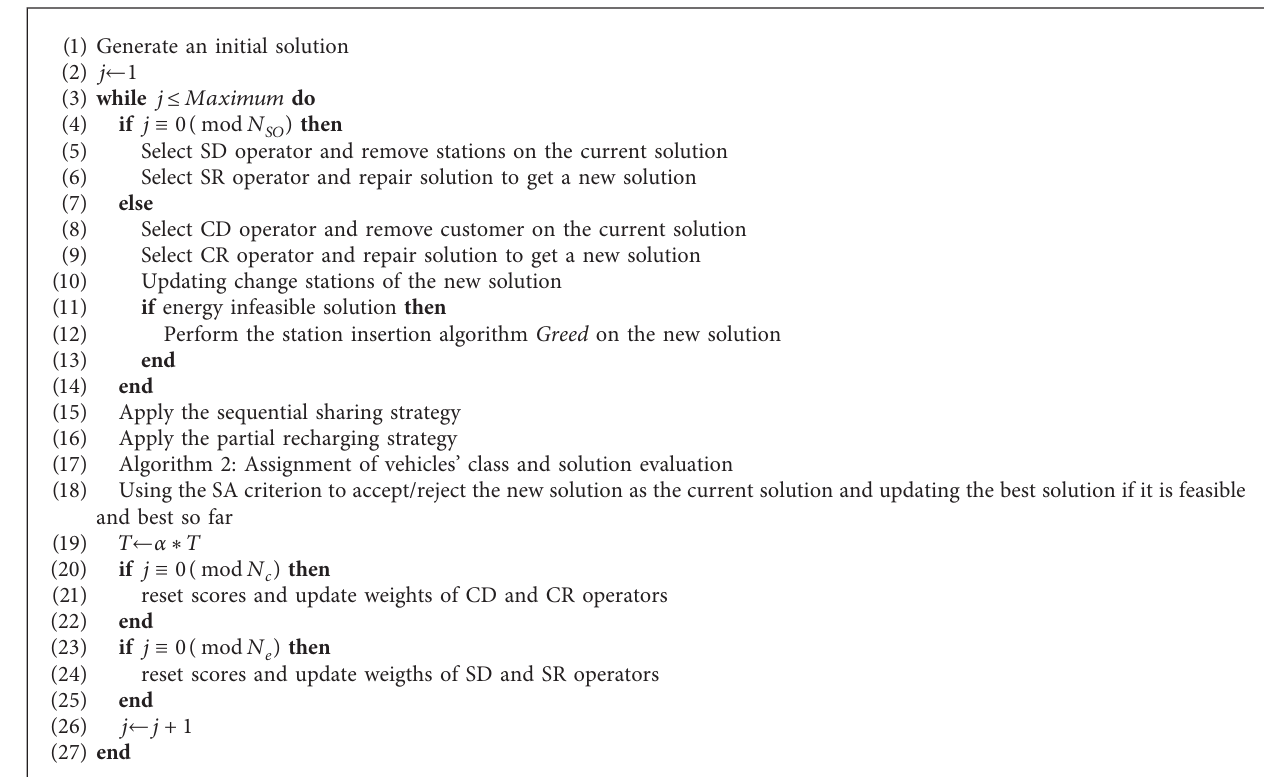
Algorithm 2: Assignment of vehicles’ class and solution evaluation